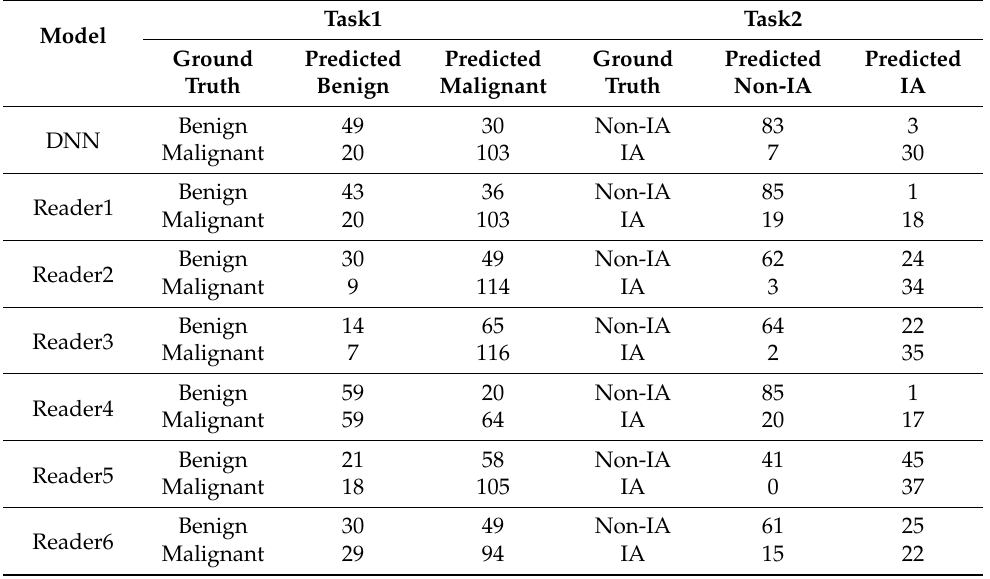
Table A2. The confusion matrix of two tasks generated by DNN and six